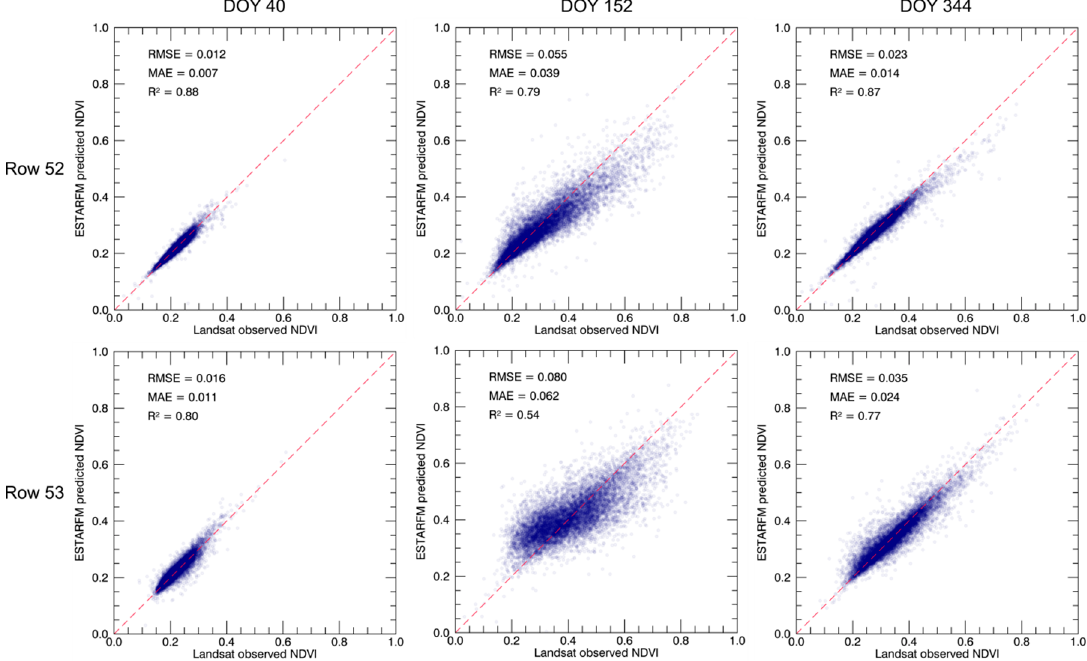
Figure 9. Scatterplots of observed Landsat versus predicted ESTARFM NDVI values for Landsat path 194 for three selected dates representing the late dry season in early 2014 (DOY 40), the vegetative season (DOY 152) and the early dry season at the end of 2014 (DOY 344). Upper three plots show Landsat row 52, lower three plots Landsat row 53.